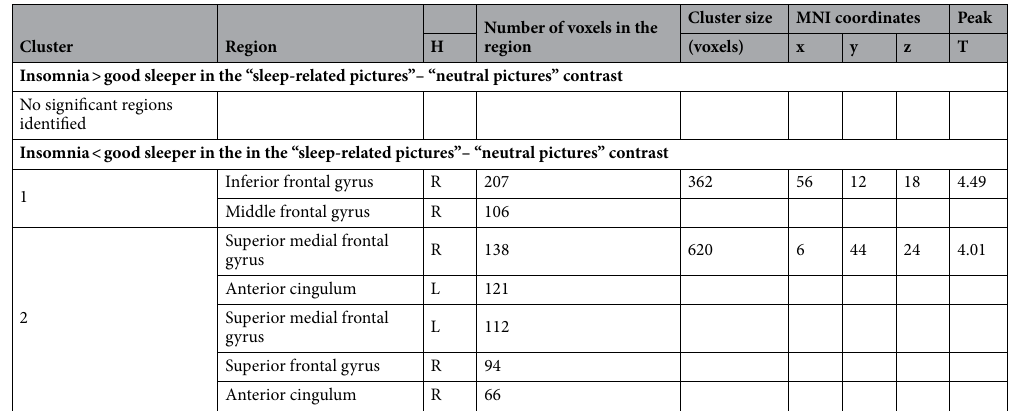
Table 2. Comparison of brain activation in response to sleep-related pictures between the insomnia patients and good sleepers.